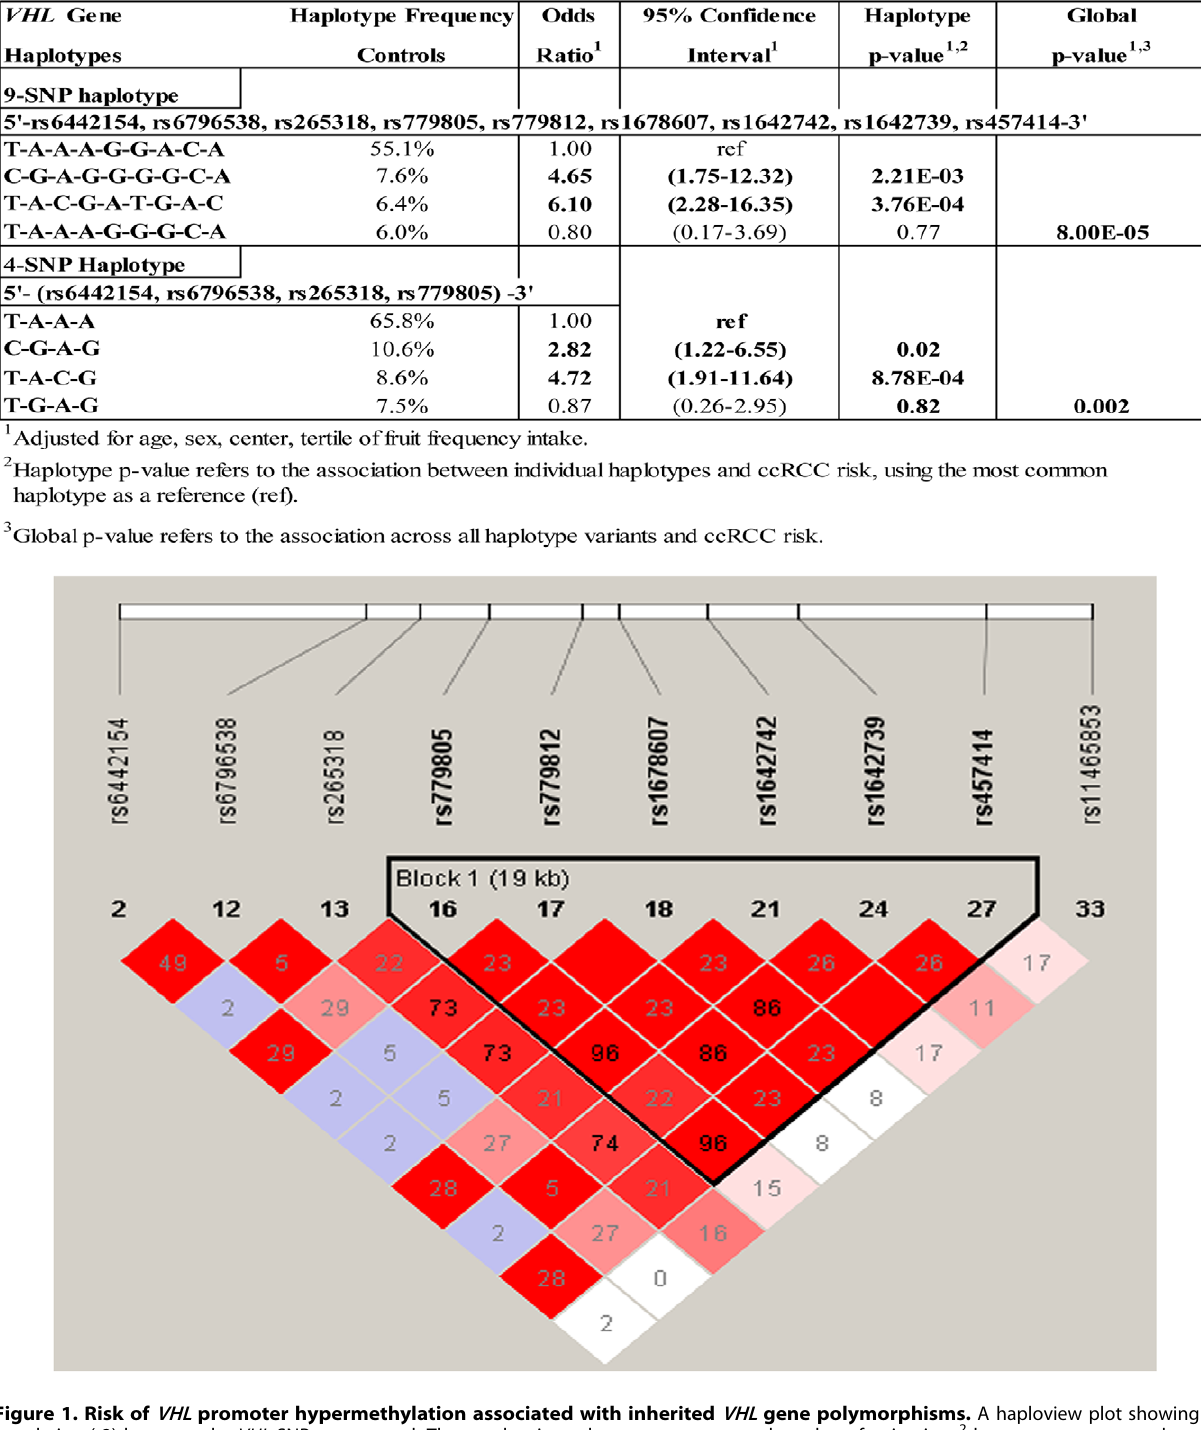
Figure 1. Risk of VHL promoter hypermethylation associated with inherited VHL gene polymorphisms. A haploview plot showing the correlation (r2) between the VHL SNPs genotyped. The number in each square represents the value of pair wise r 2 between any two